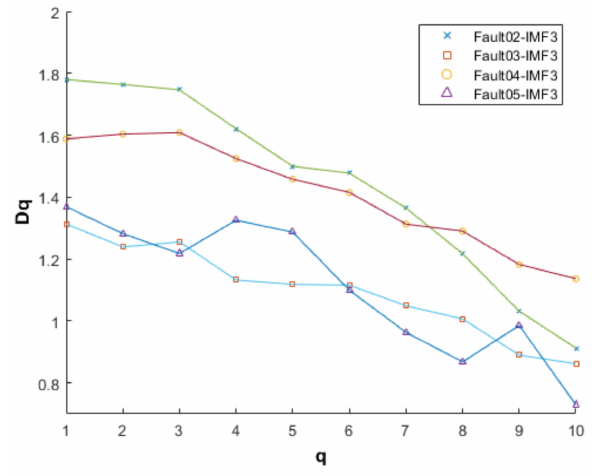
Figure 22. IMF3‑VMD mathematical morphology fractal dimension map. Table 4. Characteristic sample of the fault signal analysis